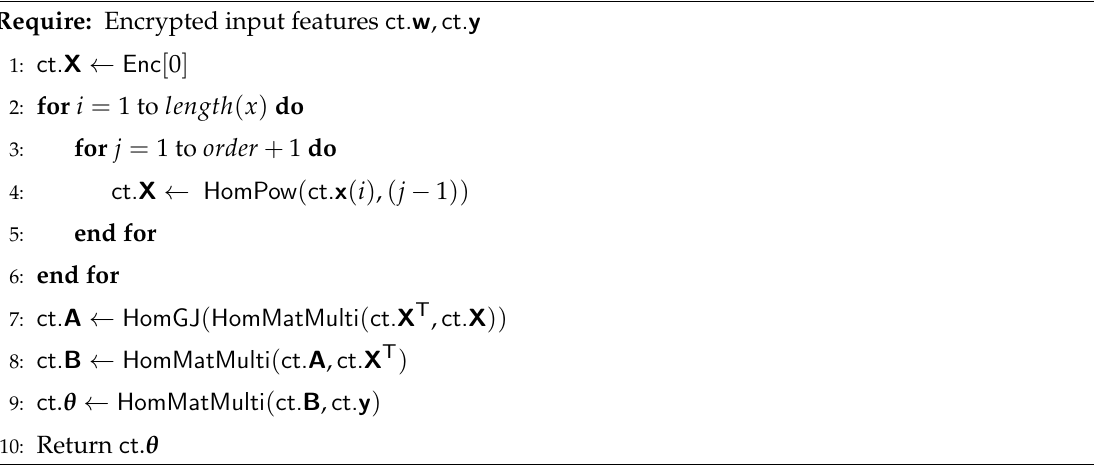
Algorithm 7 Homomorphic Regression Coefficients for each model